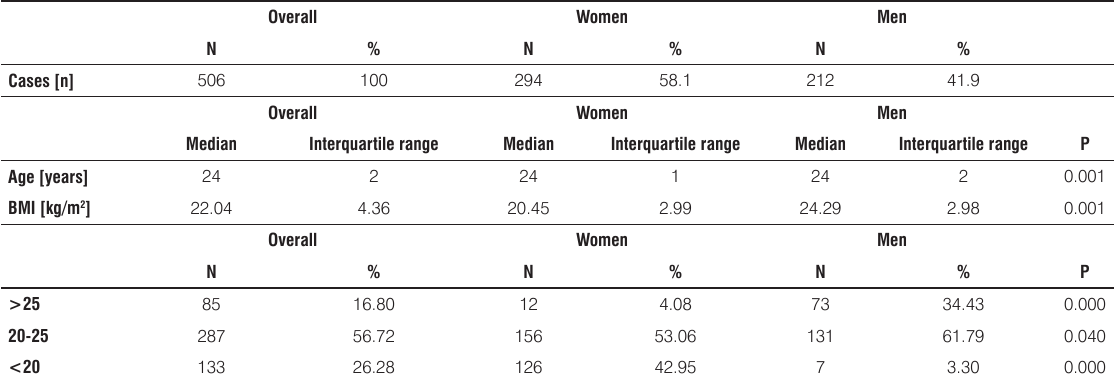
Table 1. Characteristics of the StudHeart study